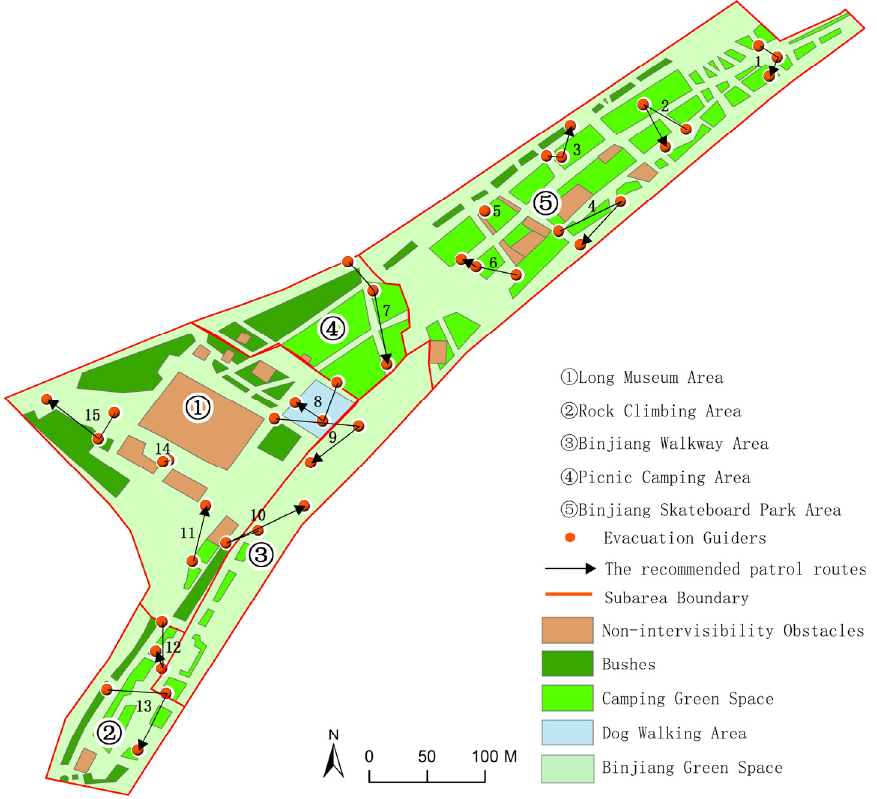
Figure 14. The recommended patrol routes of evacuation guiders from 18:00–19:00 on 5 May 2021.